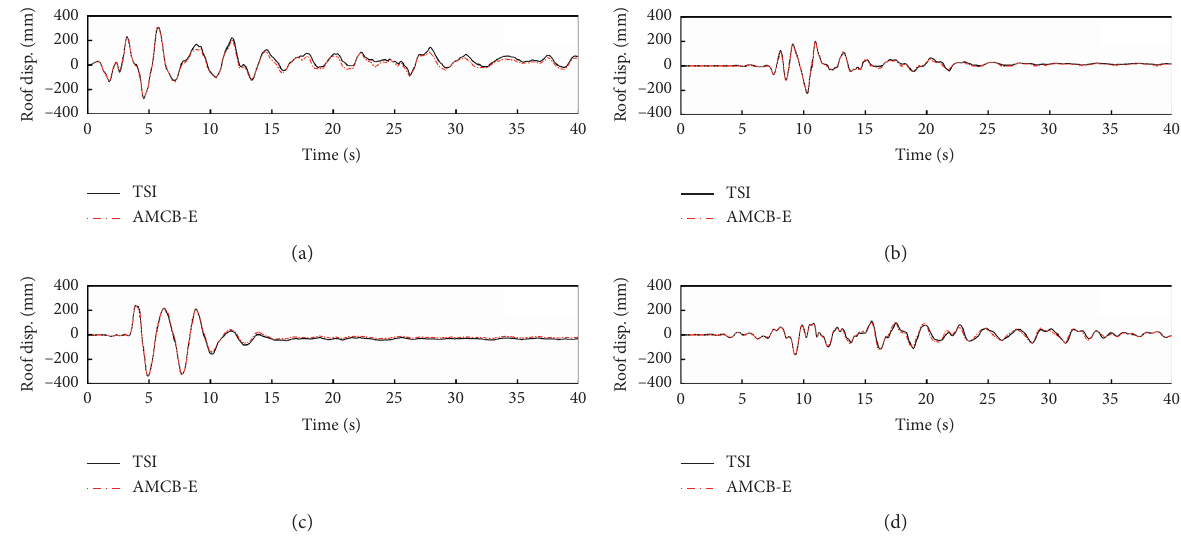
Figure 8: Time histories of roof displacements. (a) El Centro. (b) Kobe. (c) Northridge. (d) Parkfield.